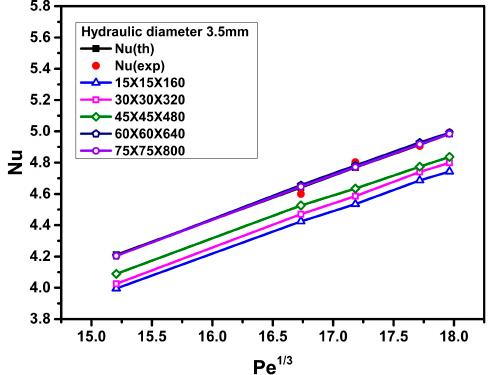
Figure 2. Grid sensitivity testing and comparison among numerical, theoretical, and experimental data for the Nusselt number of water (hydraulic diameter D h = 4.2 mm).